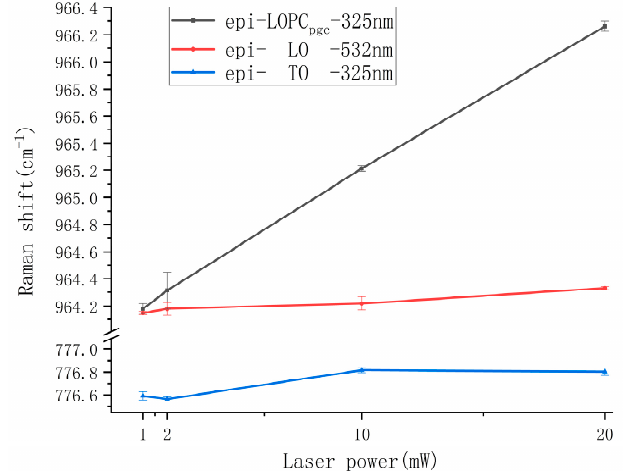
Figure 7. Dependence of Raman peak position of the TO & LOPC pgc modes for epi samples on laser power for exciting line at 325 and 532 nm.